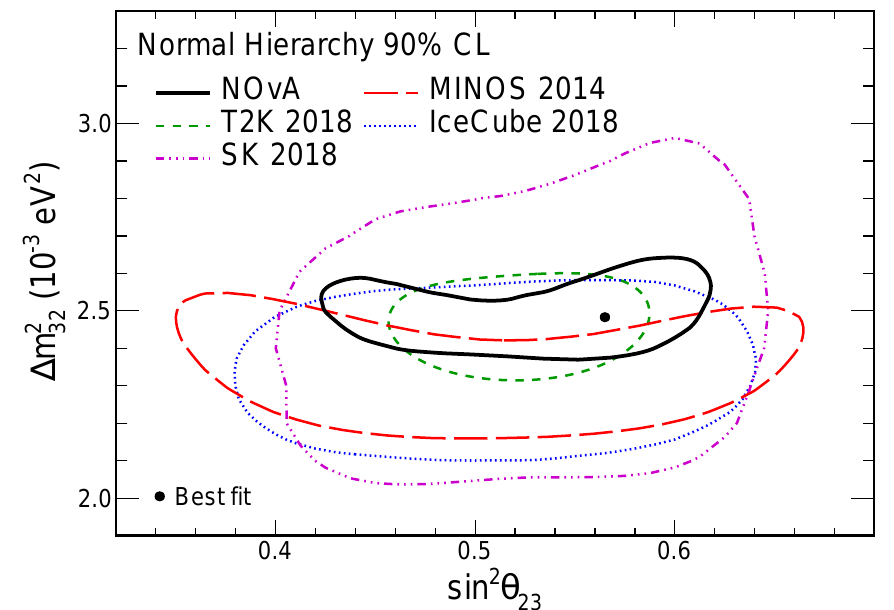
Figure 6. ∆ m 2 versus sin 2 θ 23 (90% CL) measured by NO ν A, T2K, MINOS+, and atmospheric 23 neutrino